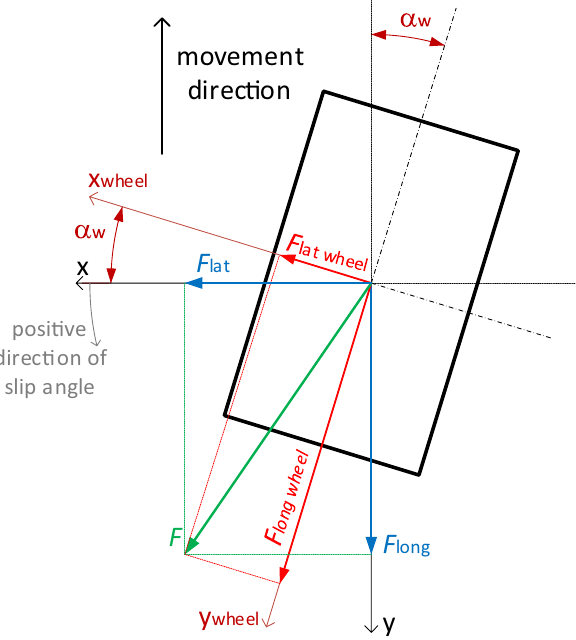
Figure 3. Geometrical model of the wheel, top view. x–y—coordinate axes relate to the movement direction, x wheel –y wheel —coordinate axes related to the wheel geometry, F long —measured longitudinal force related to the movement direction, F lat —measured lateral force related to the movement direction, F—the resultant force related to coordinate axes of movement direction, F long wheel —longitudinal component of the force related to geometrical wheel axes, Flat wheel—lateral component of the force related to geometrical wheel axes, α w —slip angle (between movement direction and wheel coordinate system) 16 .